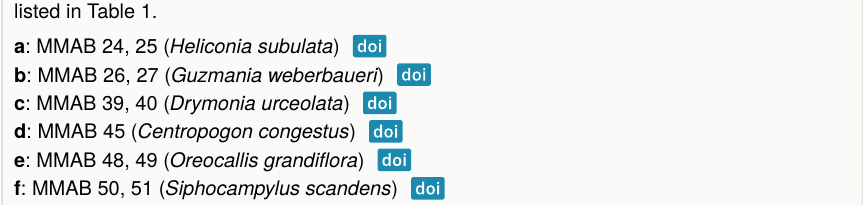
Diversity of putatively bird pollinated plants of the Manú Gradient. MMAB collection numbers listed in Table